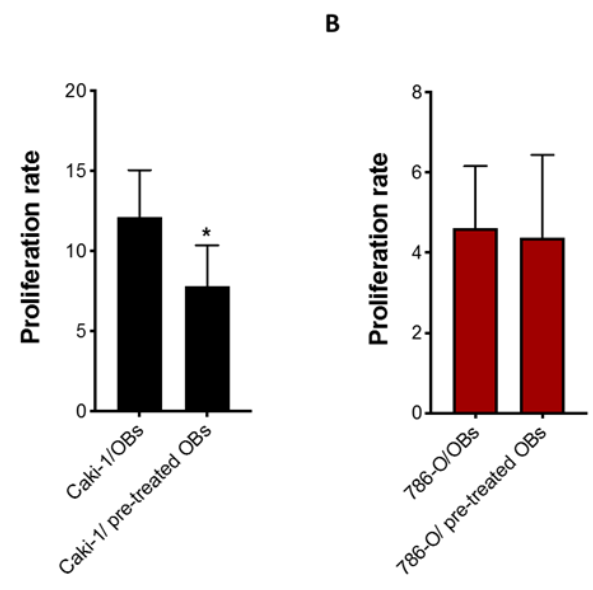
Figure 5. The antitumor effect of cabozantinib mediated by OBs. The proliferation rate of Caki-1 GFP+ ( A ) and 786-O GFP+ ( B ) cells cultured with OBs pretreated with cabozantinib (5 μM). Data are expressed as the mean ± SD; * p ≤ 0.05.